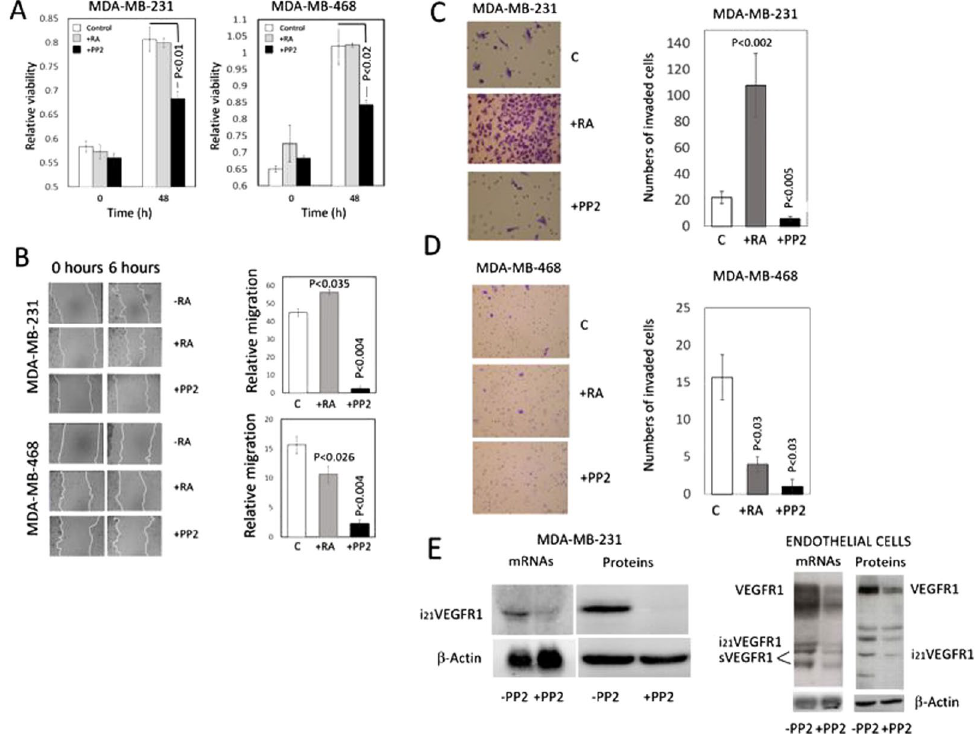
Figure 3. Effect of retinoic acid and the Src inhibitor PP2 on viability, migration, and invasiveness of MDA-MB-231 and MDA-MB-468 breast cancer cells i n vitro . Consequences of Src inhibition on the VEGFR1 expression on MDA-MB-231 breast cancer cells and endothelial cells. Prior assessment of viability, migration, and invasion cells were incubated for 48 h in the presence of 5 μ M RA or 10 μ M PP2. ( A ) Cell viability of MDA-MB-231 and MDA-MB-468 breast cancer cells incubated in the presence of RA or the Src inhibitor PP2. In both MDA-MB-231 and MDA-MB-468 breast cancer cell lines, cell viability did not change in the presence of RA and decreased upon Src inhibition by PP2. The bar graphs show quantification of data from three independent experiments. ( B ) Effect of retinoic acid and Src inhibitor PP2 on the migration of MDA-MB-231 and MDA-MB-468 breast cancer cells i n vitro . The cell layer of breast cancer cells treated with either RA or PP2 was streaked with a sterile pipet tip to assess migration, and the wound was allowed to recover for 6 hours. Following recovery, the remaining uncovered wound area was measured, and relative migration was calculated as the percentage of wound area covered by cells. In MDA-MB-231 cells, migration increased by retinoic acid and decreased markedly upon Src inhibition. In MDA-MB-468 cells, migration decreased by retinoic acid and decreased markedly upon Src inhibition. The bar graphs show quantification of data from three independent experiments. ( C and D ) Effect of RA and the Src inhibitor PP2 on invasiveness of MDA-MB-231 and MDA-MB-468 cells in vitro . Breast cancer cells were treated with either RA or PP2, seeded on polycarbonate filters coated with Matrigel, as described in the Materials and Methods Section, and incubated for 24 h. Quantification of invaded cells represents the mean number of cells per field counting seven random fields at 40 × or 20 × magnification. Treatment with 5 μ M RA markedly increased cell invasion in MDA-MB-231 cells (P < 0.0001 vs. control cells) while a decrease was observed in MDA-MB-468 cells. Treatment with the Src inhibitor PP2 (10 μ M) suppressed cell invasion in both types of cells. E) Consequences of Src inhibition on the VEGFR1 expression in MDA-MB-231 breast cancer cells and endothelial cells. Cells were incubated in the absence ( − ) or presence ( + ) of the Src inhibitor PP2. In MDA-MB-231 breast cancer cells, Northern blot analyses show that the expression of the pro-invasive intracellular isoform i 21 VEGFR1 decreases upon Src inhibition. Western blot analyses show that the protein i 21 VEGFR1 decreases after Src inhibition. In endothelial cells (HUVEC), Northern blot analyses show that the expression of all VEGFR1 isoforms decreases upon Src inhibition. Western blot analyses show that all the isoforms detected by the antibody against the tyrosine domain of VEGFR1 decrease after Src inhibition. β -Actin was used as loading control. Full-length figures of the cropped blots are in Supplementary Figures